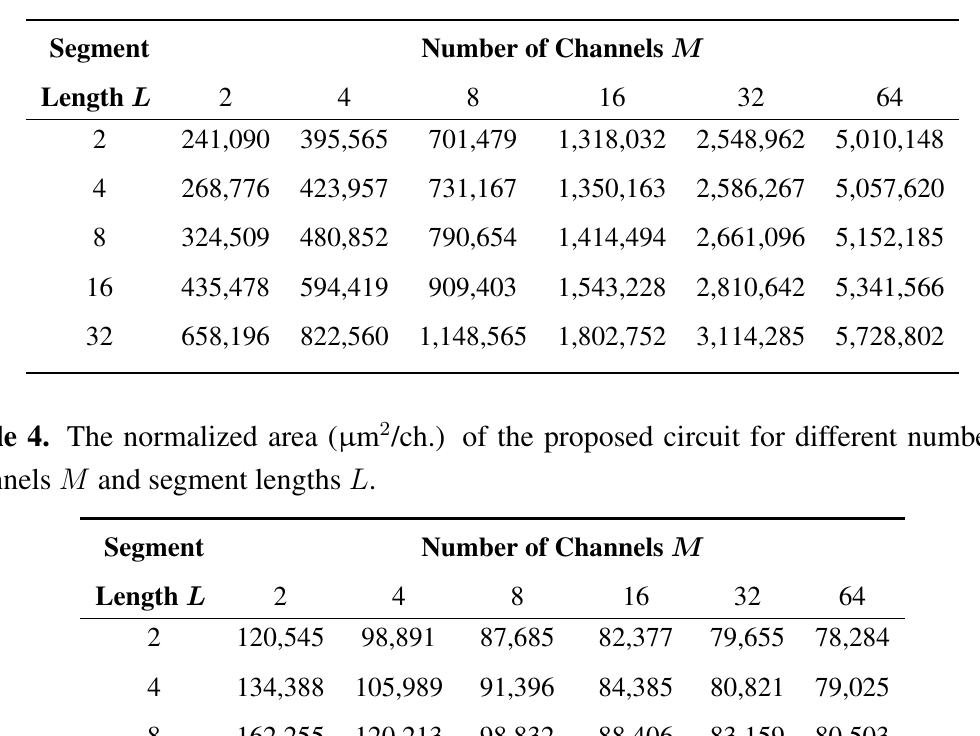
Table 3. The area ( µ m 2 ) of the proposed circuit for different numbers of channels M and segment lengths L .